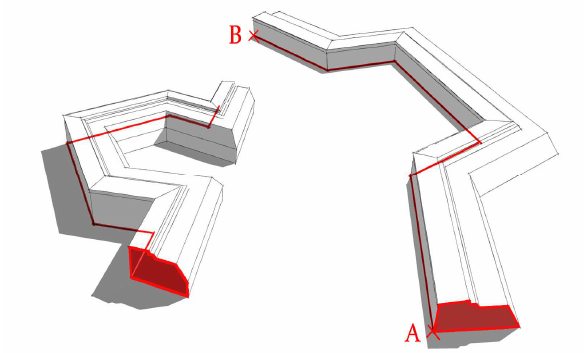
Figure 3. Profiles and trajectories lines for a bastion (left) and a bastioned front (right).